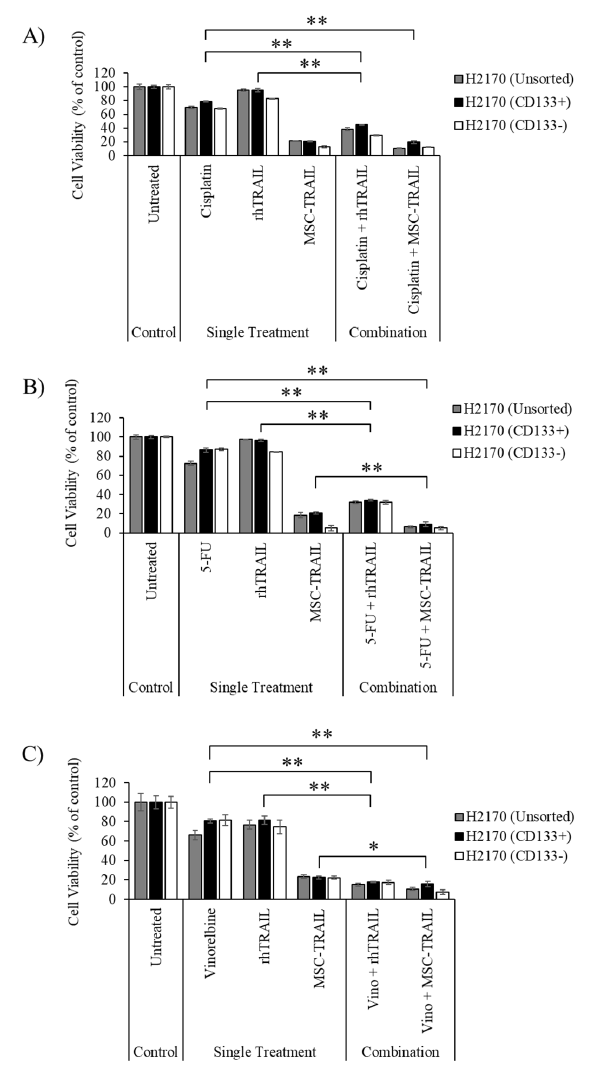
Figure 5. The effect of chemotherapy pre-treatment on the efficacy of MSC-TRAIL in H2170-derived CD133+ cells. ( A ) The pre-treatment using cisplatin was not able to enhance the effect of MSC-TRAIL in H2170-derived CD133+ CSCs. ( B , C ) Pre-treatment using either 5-FU or vinorelbine/vino was able to increase the cytotoxic effect of both MSC-TRAIL and rhTRAIL to kill the CSCs (** p < 0.001, * p < 0.01; t -test, n = 3). 5-FU, 5-fluorouracil; Vino,